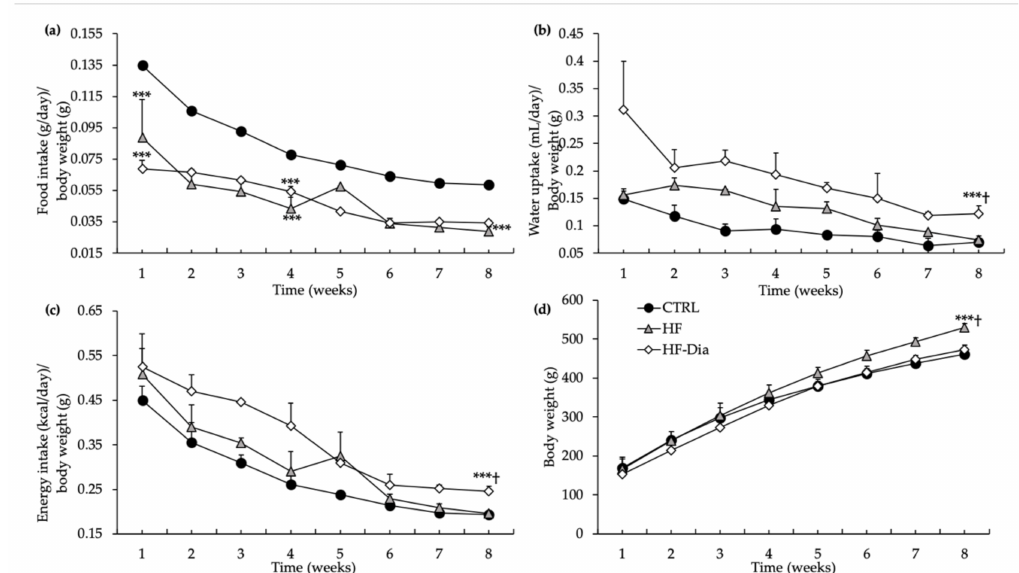
Figure 1. Effect of D. lutheri supplementation on food intake ( a ), water intake ( b ), energy intake ( c ) and body weight ( d ). CTRL ( ), control group; HF ( ), high-fat group; HF-Dia ( ), HF supplemented with D. lutheri group. Values are means ( n = 6), with standard deviations represented by vertical bars. Statistical significance was determined using ANOVA with post hoc Fisher’s test and mean values were significantly different from those of the CTRL group with *** p < 0.001. † Significant difference in the HF-Dia group compared with the HF group ( p <